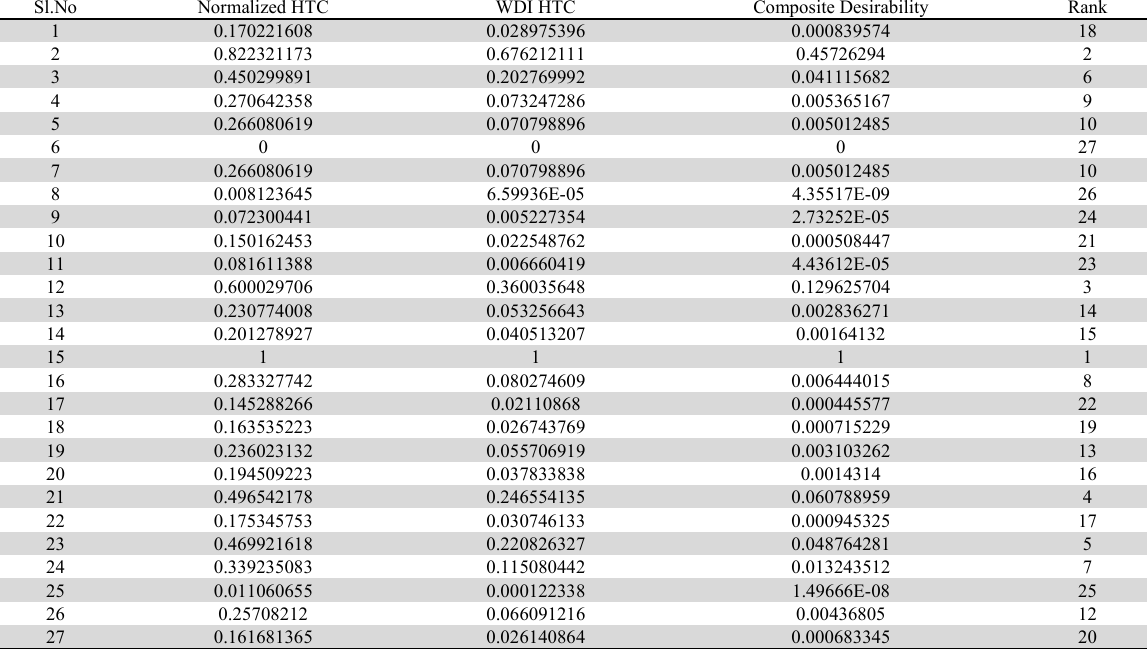
Evaluated results of desirability function Sl.No